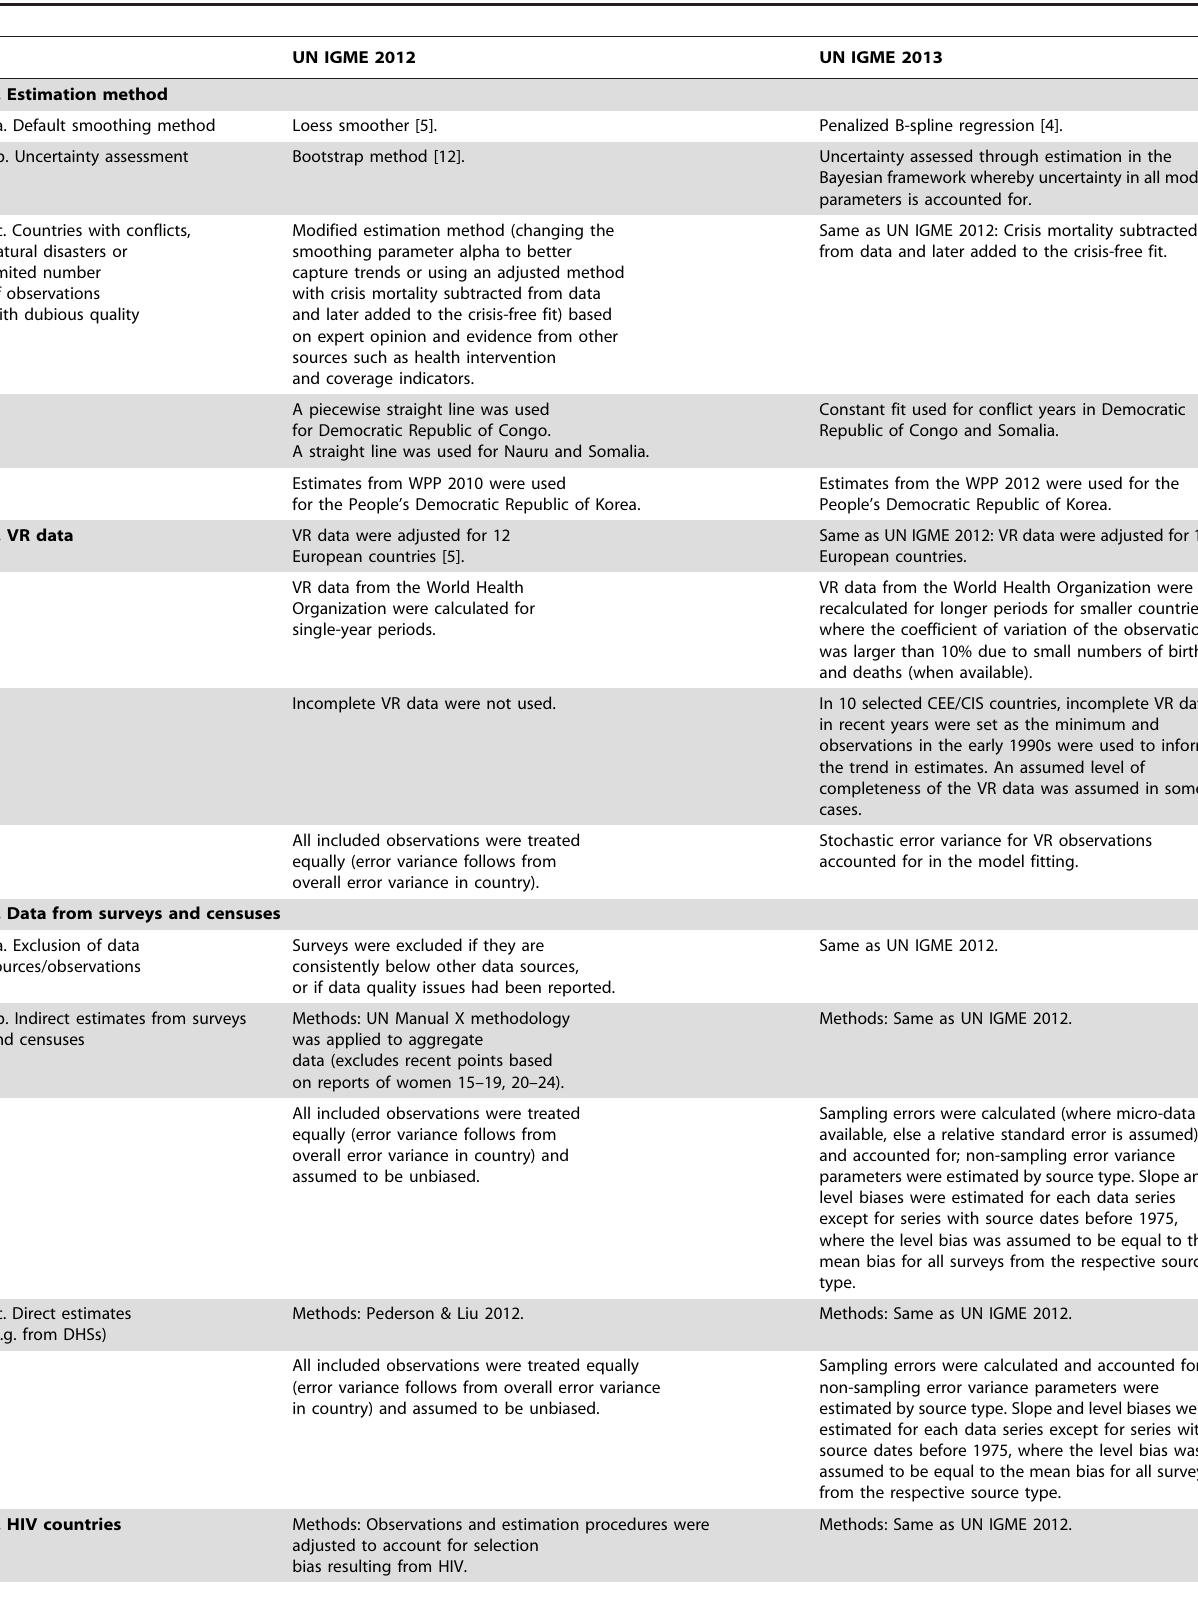
Table 1. Overview of differences in modelling approach and datasets used by UN IGME 2012 and UN IGME 2013, for estimating the U5MR and the number of under-five